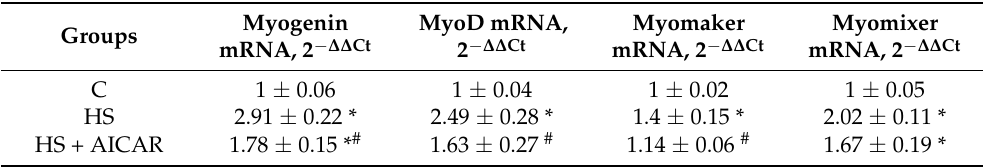
Table 4. Expression level of differentiation markers in myoblasts derived from the atrophied rat soleus muscle. Values are means ± SEM. C—myoblasts derived from rat soleus muscle of the control rats, HS—myoblasts derived from rat soleus muscle after 7-day HS, HS+AICAR—myoblasts derived from rat soleus muscle after 7-day HS and treated with AICAR; n = 7/group. *—significant difference vs. C, p < 0.05, #—significant difference vs. HS, p < 0.05.